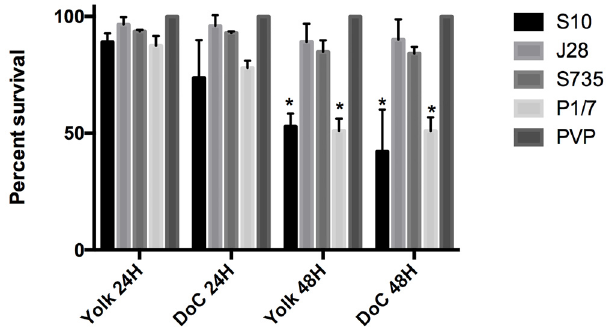
Fig 5. Microinjection in the yolk sac or the ducts of Cuvier leads to similar mortality rates. Survival rate of injected larvae with four different S . suis strains in two different infection sites, the yolk sac and the Ducts of Cuvier, no significant difference between the two infection sites was found ( p = 0.0536). The surviving larvae were counted at 24 and 48 hpi. * P-value < 0.01 compared with J28, S735 and PVP control group. Results were obtained in 3 independent experiments, and 25 larvae were injected per